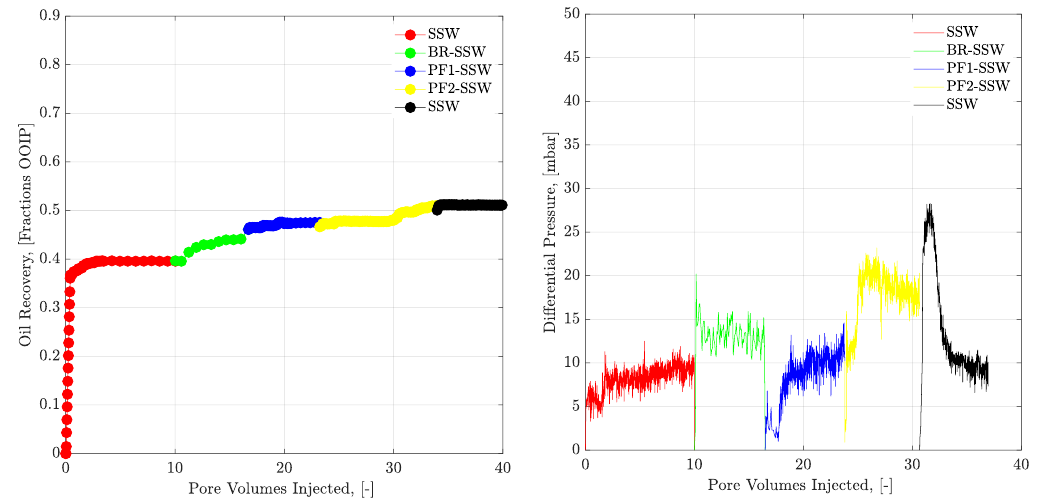
Figure 20. Oil recovery and pressure drop versus PV injected for complex-wet artificial structure micromodel. Polymer (equal to the oil viscosity) flooding in post-tertiary mode after the SSW brine flood in secondary mode.